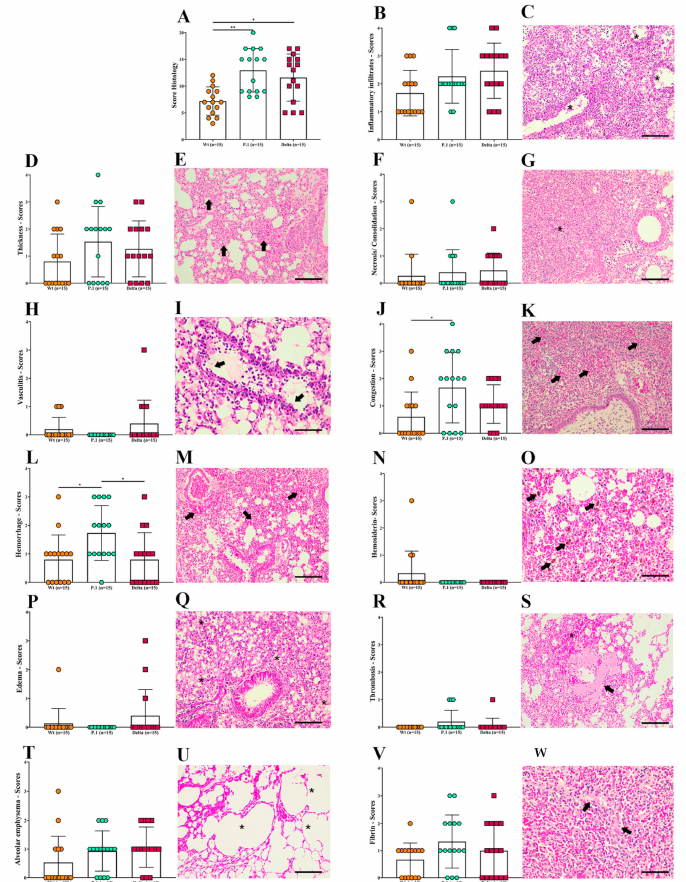
Figure 3. Histopathological changes in the lungs of K18-hACE2 mice after infection with the Wt strain, or the P.1 or Delta SARS-CoV-2 variants. ( A ) The sum of all histological parameters analyzed per group. ( B , D , F , H , J , L , N , P , R , T , V ) Individual histological parameters were quantified in three groups of infected mice. ( C , E , G , I , K , M , O , Q , S , U , W ) Representative photomicrographs of SARS-CoV-2-infected mice lungs. ( C ) Severe interstitial pneumonia with a mixed inflammatory infiltrate vasculitis and peri-vascular infiltrate (asterisks) from a P.1-infected mouse on the 5th dpi (20 × ). ( E ) Interstitial pneumonia with thickness of alveolar septa (arrows), from a Wt-infected mouse on the 6th dpi (20 × ). ( G ) Interstitial pneumonia showing extensive inflammatory infiltrate and consolidation area (asterisk) from a Wt-infected mouse on the 7th dpi (20 × ). ( I ) Vein vasculitis and diapedesis (arrows) of polymorph and mononuclear cells from a Wt-infected mouse on the 7th dpi (40 × ). ( K ) The congestion (arrows) and severe bronchopneumonia with extensive inflammatory infiltrate and consolidation, showing exudate inside bronchioles (asterisks) from a P.1-infected mouse on the 5th dpi (20 × ). ( M ) Extensive and diffuse hemorrhagic areas (arrows) associated with inflammatory infiltrate from a Wt-infected mouse euthanized on the 5th dpi (20 × ). ( O ) Brownish hemosiderin pigments (arrows) visualized in an extensive hemorrhagic area in a Wt-infected mouse on the 5th dpi (40 × ). ( Q ) Alveolar oedema, evidenced by light eosinophilic areas (asterisks) and reactive alveolar macrophages (arrows) from a Wt-infected mouse on the 7th dpi (20 × ). ( U ) Emphysema alveolar areas (asterisks) in a Wt- infected mouse on the 7th dpi (20 × ). ( S ) White thrombus (arrow) surrounded by bleeding (asterisks) and congested areas. The right upper area shows emphysema in a P.1-infected mouse on the 5th dpi (20 × ). ( W ) Fibrin (arrow) and congestion areas (asterisks) in a P.1-infected mouse on the 5th dpi. Scale bars represent 40 µ m (objective 20 × ) and 20 µ m (objective 40 × ). Wild type = Wt; dpi = days post infection. Data are representative of three independent experiments. Non-parametric variables were compared using Kruskal–Wallis test which was followed by Dunn’s post hoc test using GraphPad Prism 8.0, p < 0.05 was considered significant (* p ≤ 0.05 and ** p ≤